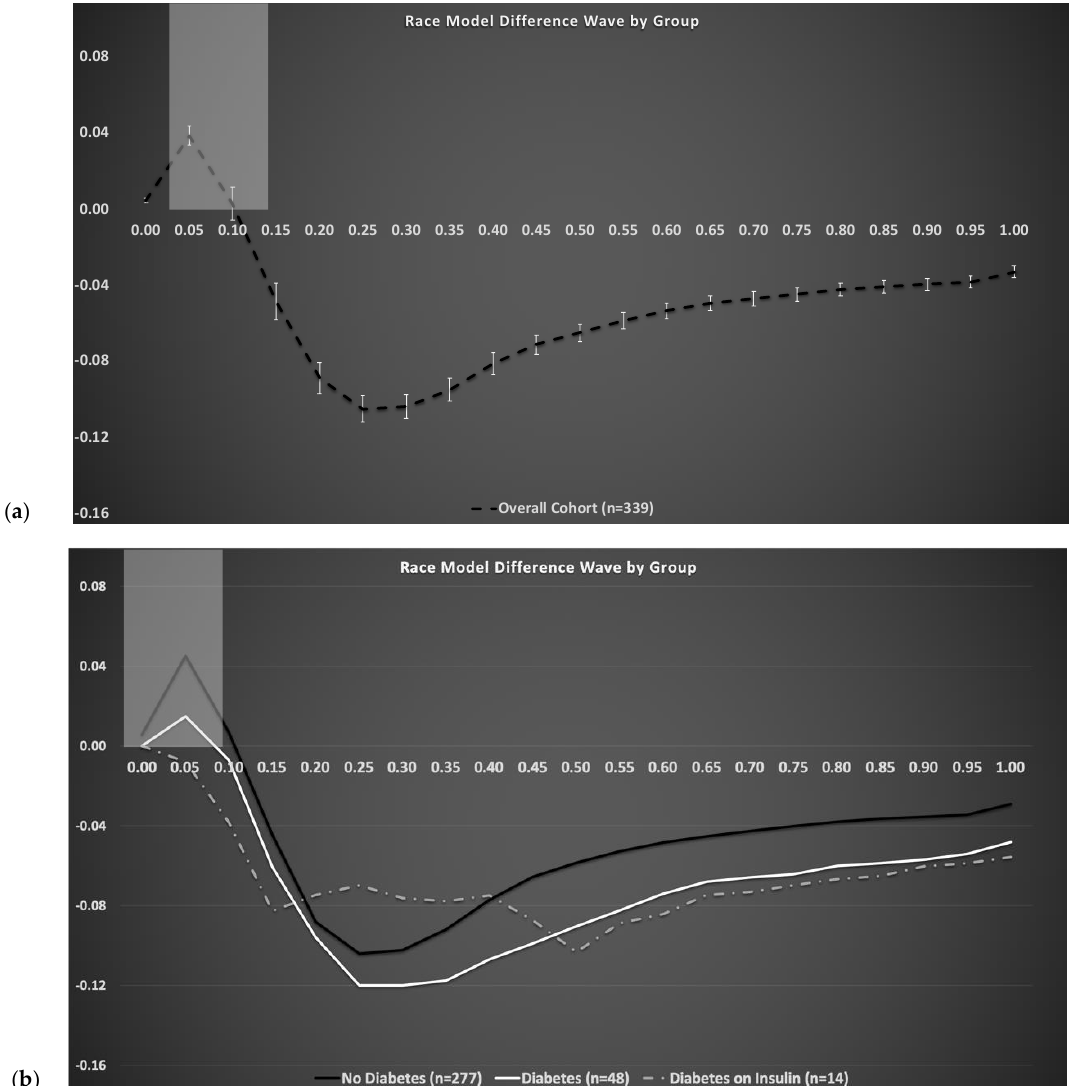
Figure 2. Test of the race model. ( a ) The CDF difference waves over the trajectory of averaged responses for the overall cohort. The grey box highlights the group averaged violated percentile bins (0–10th). ( b ) The CDF difference waves over the trajectory of averaged responses for individuals without diabetes (black trace), individuals with diabetes (white trace), and individuals with diabetes on insulin therapy (dashed trace).